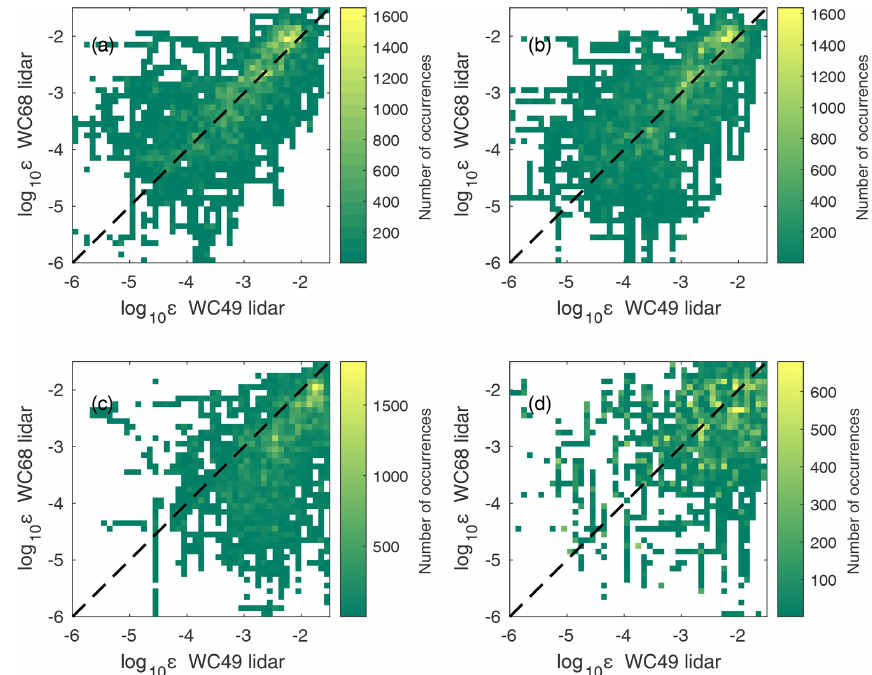
Figure 8. Heat map of log 10 ε showing the spatial variability for both WindCube lidars at 75m (a) , 105m (b) , 135m (c) , and 160m (d) . The shading indicates the number of occurrences of each value of log 10 ε for each lidar. The values of turbulence dissipation rate are averaged over a 30min time period. The black dashed line shows a 1 : 1